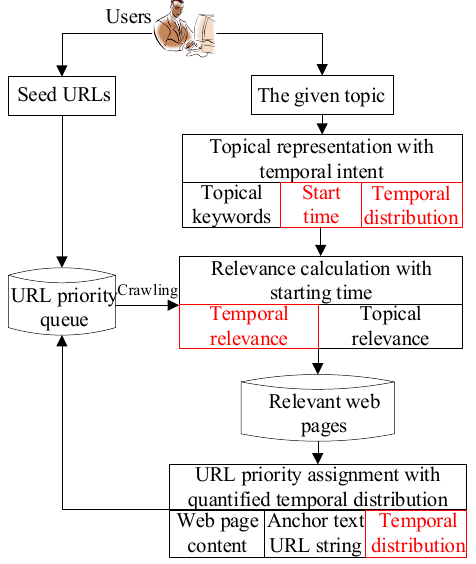
Figure 2. The conceptual framework of our focused